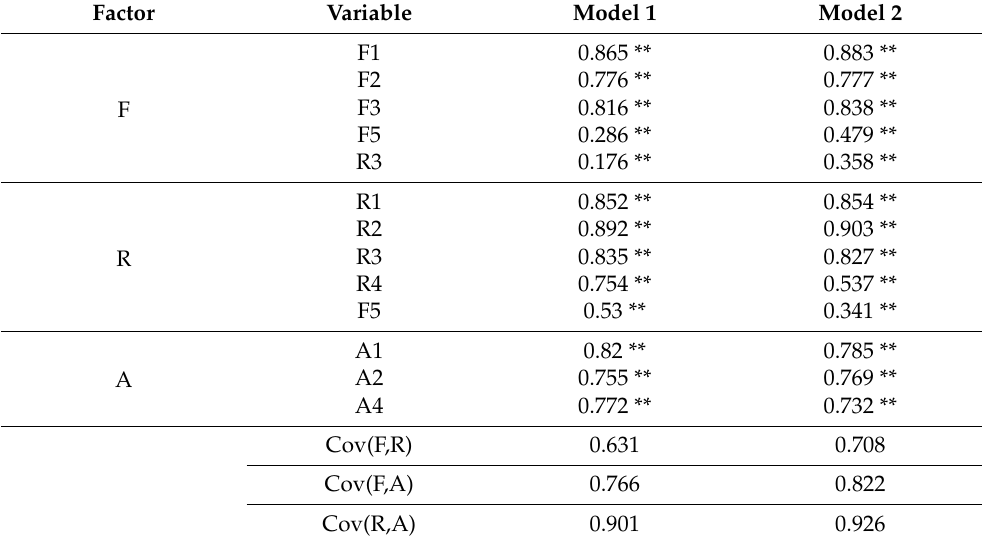
Table 4. Estimated